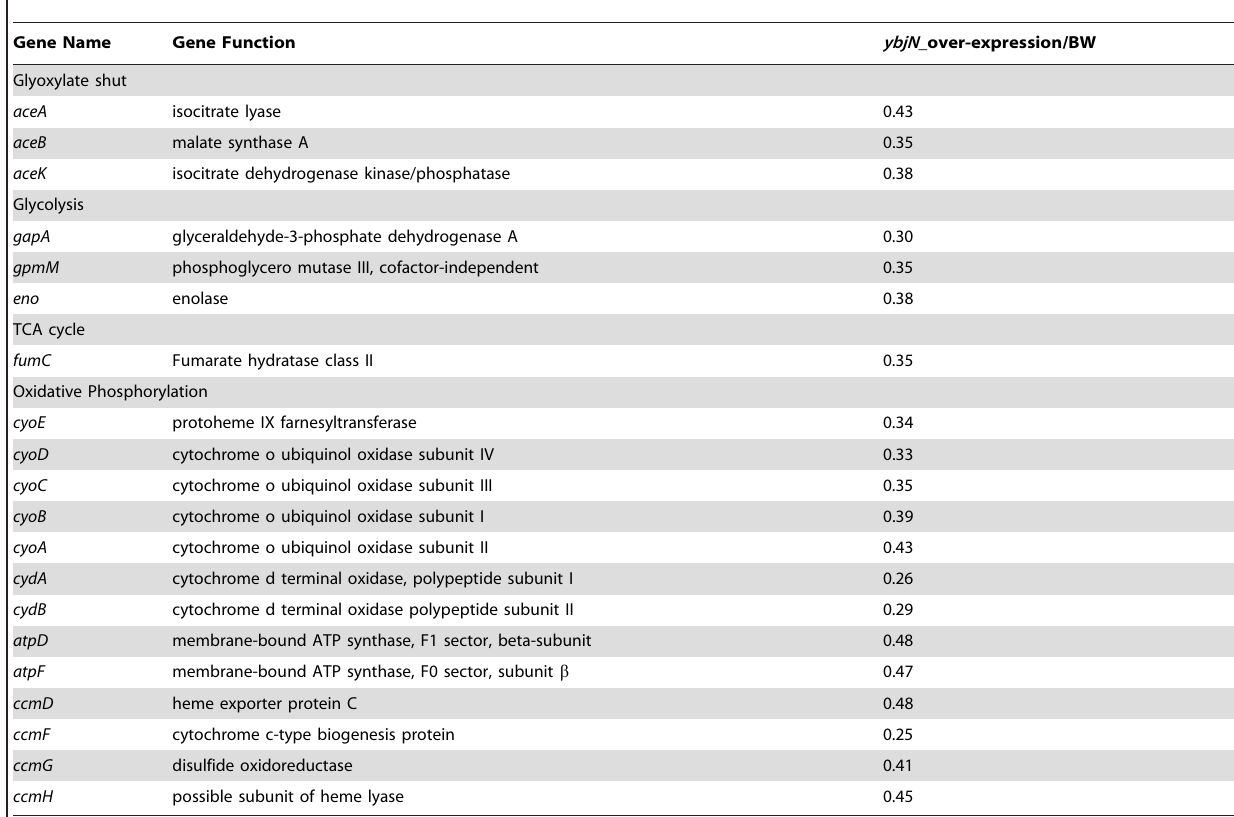
Table 3. Carbohydrate catabolism genes that are suppressed in ybjN over-expression strain (p-value , 0.05).